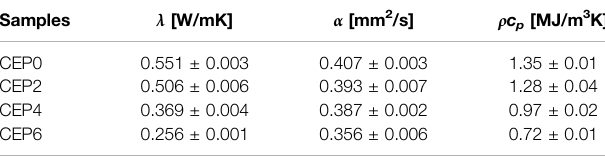
TABLE 2 | The thermal properties of CEP composites.